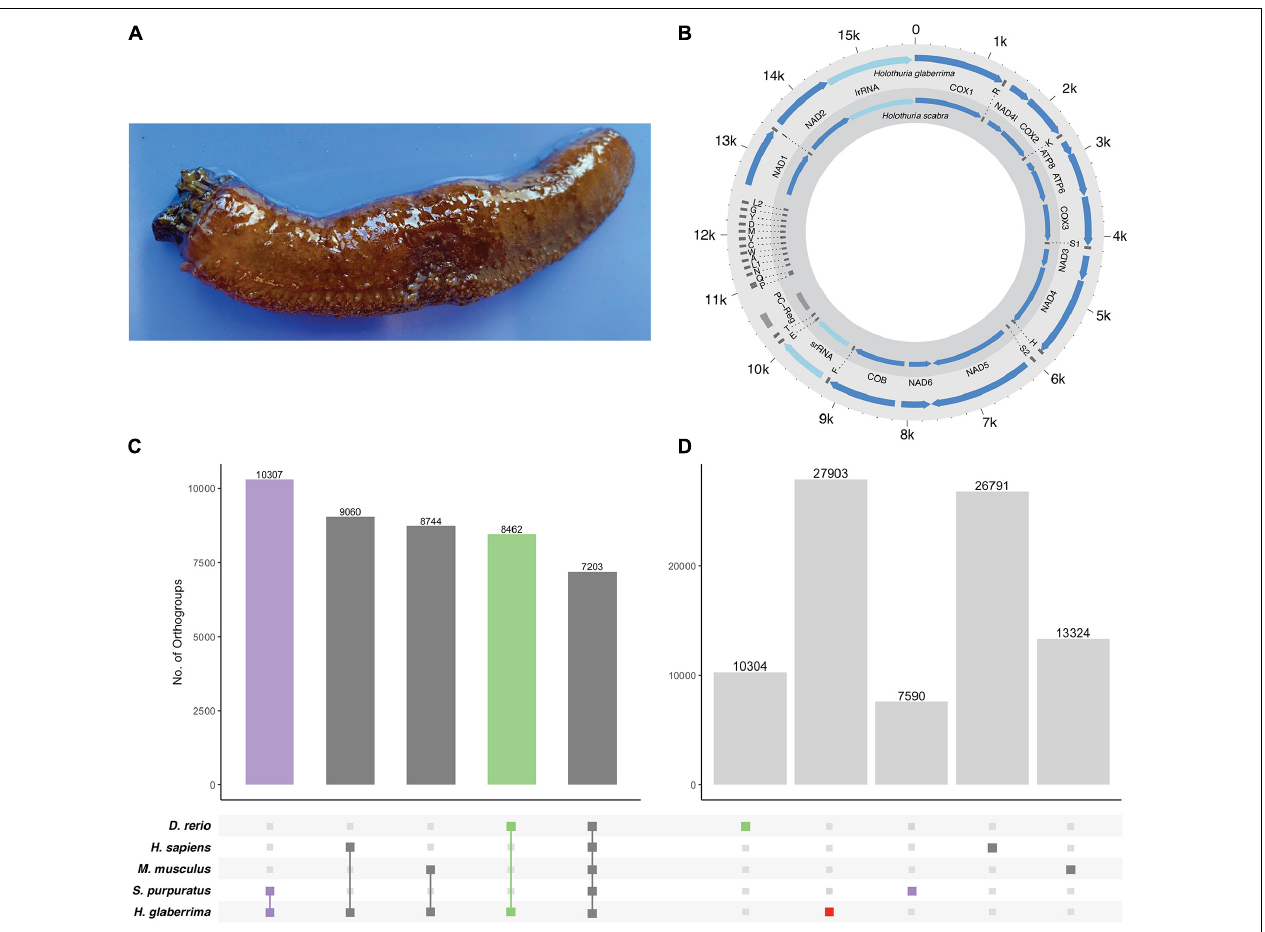
FIGURE 1 | H. glaberrima mitochondrial genome and orthogroup analysis. (A) The sea cucumber H. glaberrima. (B) Comparison of mitochondrial features of H. glaberrima (outer) and H. scabra (inner). Genes = blue, rRNA = light blue, tRNA = dark gray, PC region = light gray. (C,D) Gene content distribution in echinoderm and vertebrate lineages. Filled circles in the bottom panel indicate (C) shared and (D) species-specific orthogroups in those lineages. Bar graphs indicate the number of orthogroups corresponding to each filled-circle pattern. (C) OrthoFinder analyses were performed with amino acid sequences of H. glaberrima protein models (based on predicted gene models), D. rerio, H. sapiens, M. musculus, and S. purpuratus. Total orthogroup overlap between H. glaberrima and each other species as well as total orthogroups shared between all species. (D) Species-specific orthogroups (OGs) for all species analyzed. These include singlets – sequences that didn’t form a group with any other sequence in the analysis and orthogroups consisting of only sequences from a single